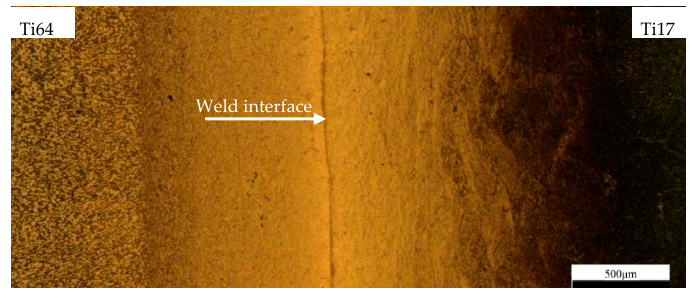
Figure 2. Configurations of specimens for ( a ) tensile and ( b ) impact toughness tests.